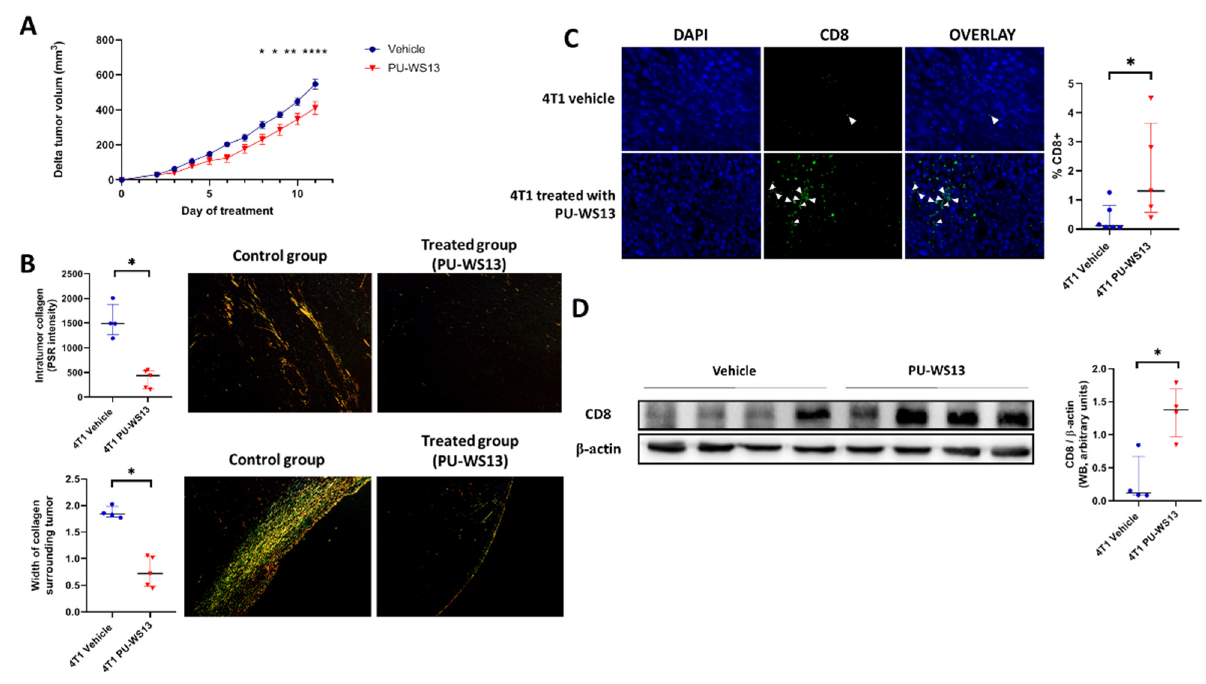
Figure 4. GRP94 inhibition by PU-WS13 limits tumor growth and collagen content and increases CD8 + cells in the TME. ( A ). 4T1 tumor growth (mm 3 ) measured daily during PU-WS13 ( n = 15) or vehicle ( n = 20) treatment from D11 up to D22 post implantation. Results are presented as the median with the interquartile range. p = 0.0436 and 0.0325, ** p = 0.0061, **** p < 0.0001, n = 20 for vehicle group and n = 15 for PU-WS13 group. ( B ). PicoSirius red staining of 4T1 tumors treated or not with PU-WS13 showing the collagen intensity within the tumor and the width (mm) of collagen surrounding the tumor. Results are presented as the median with the interquartile range. * p = 0.0159, n = 6 per group. ( C ). Representative images ( n = 6 vehicle and n = 6 PU-WS13) and quantification of CD8 staining of 4T1 tumors treated or not by PU-WS13. Results are presented as the median with the interquartile range. * p = 0.0303. ( D ). Western blot analysis of CD8 + in 4T1 tumors treated or not by PU-WS13 ( n = 4 vehicle and n = 4 PU-WS13), * p =